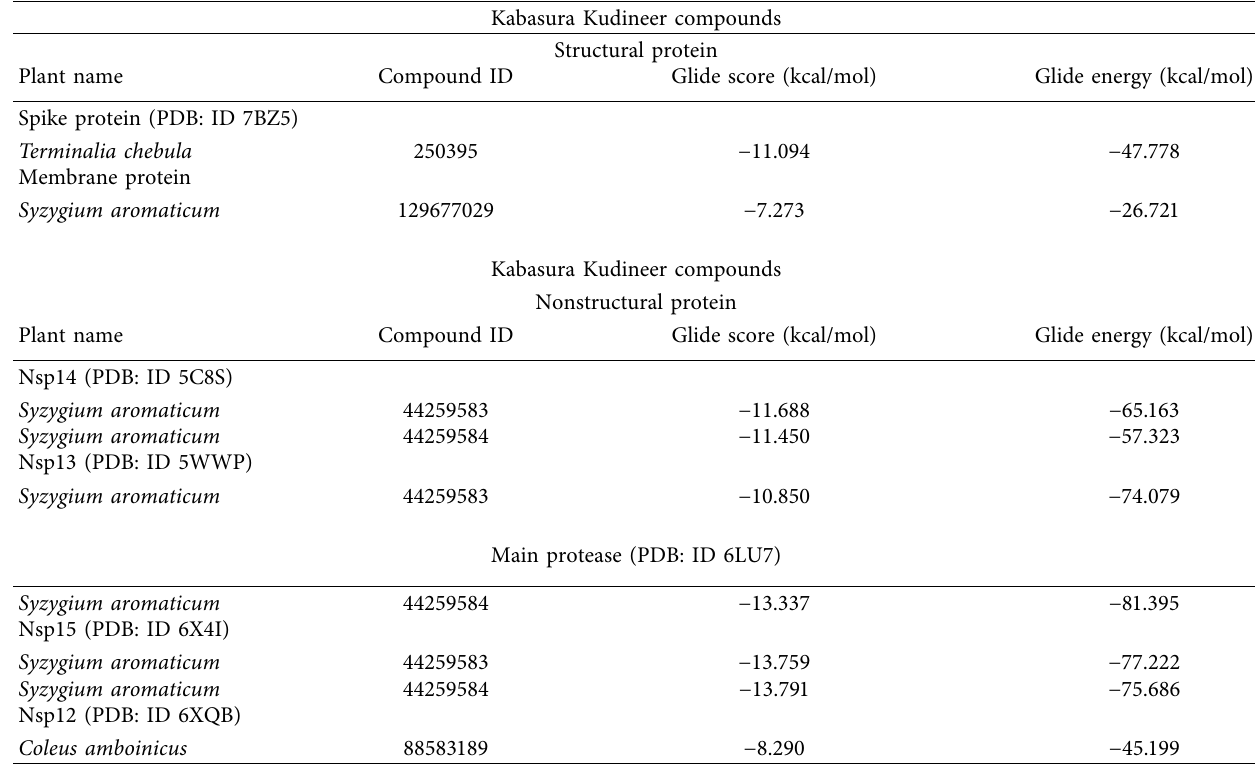
Table 2: Glide score and glide energy of homeopathy compounds with SARS-CoV-2 structural and nonstructural